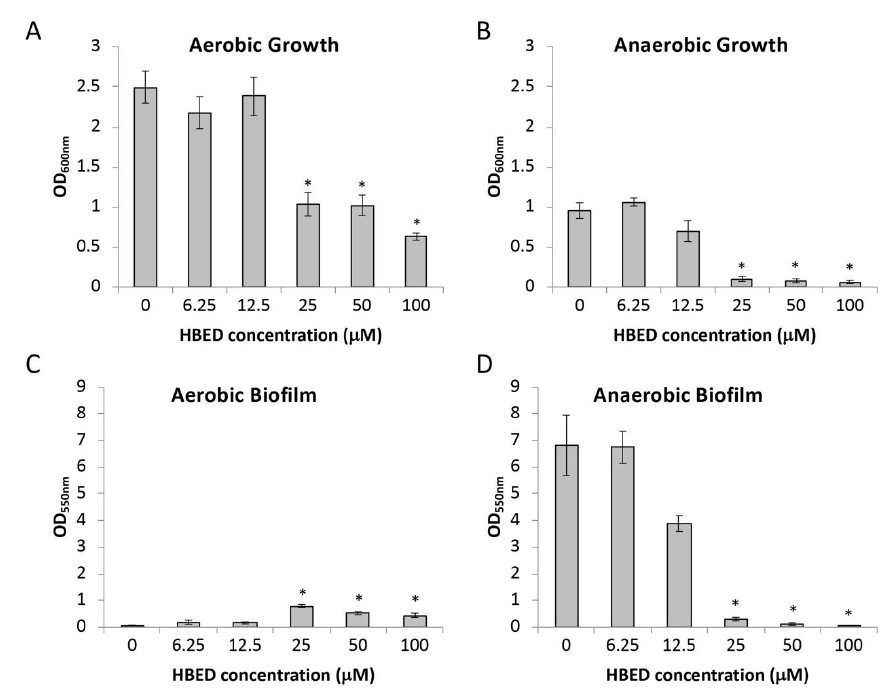
Figure 1. E ff ect of N,N’-bis (2-hydroxybenzyl) ethylenediamine-N,N’-diacetic acid (HBED) on strain PAO1 ( A , B ) growth levels, and ( C , D ) short-term biofilm formation. Growth was under aerobic ( A , C ) and anaerobic conditions ( B , D ) in succinate media with 10 µ M ferric chloride. Values shown represent the mean level of growth or biofilm formation +/ − standard error of the mean (SEM). * denotes significantly di ff erent values in the presence of HBED than without the chelator (95% confidence) determined using analysis of variance (ANOVA) with Dunnett’s Method post hoc